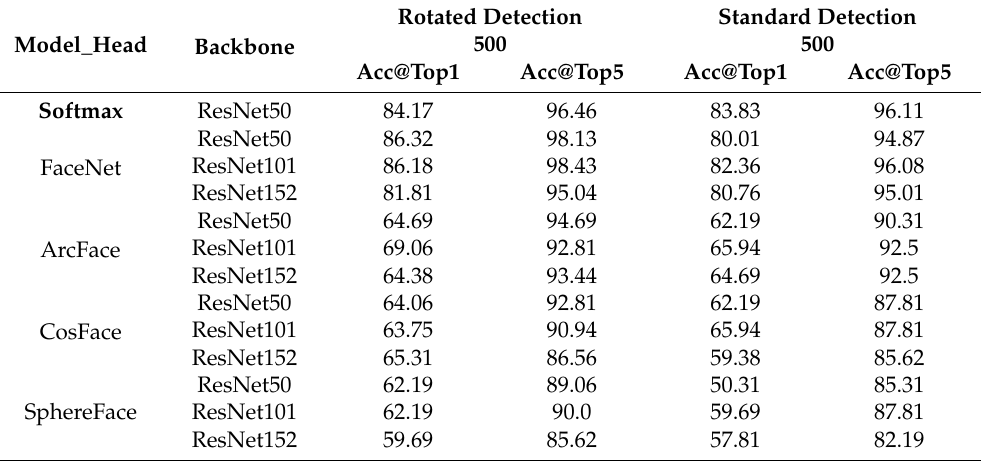
Figure 15. The picture on the left is the result after the object was detected, and the picture on the right is the result after the rotating object was detected. In the picture on the left, some fish are dense, causing some fish to be deleted by the NMS operation. The image on the right is more accurate than the image on the left, and the effect is as expected. Each detection box displays the type of object predicted (fish) and the confidence level. Table 6. Comparative experiment of traditional identification network. The data are divided into two parts: one part is the rotated and cropped picture, and the other part is the data of the standard box. The two parts of the data are the same. The purpose is to show whether the rotating object detection has an advantage, and the result obviously shows that the performance of the model in the rotation detection column exceeds most of the other